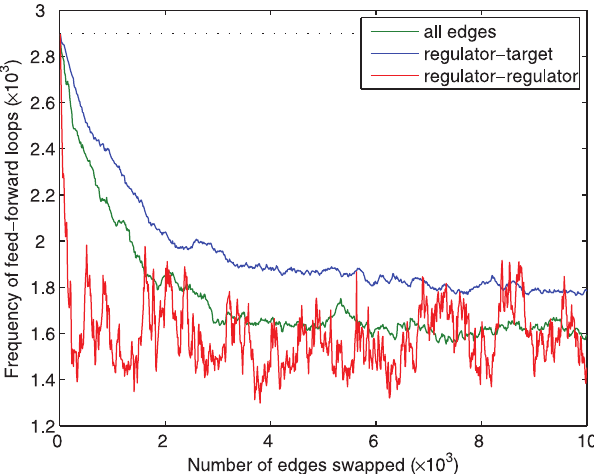
Figure 4. Frequency of FFL Motif under Different Randomization Conditions The curves were generated by starting with the observed network and swapping randomly selected pairs of edges. The green curve corre- sponds to randomization of all edges, the red curve includes random- ization of regulatory connections between TFs, and the blue curve randomization of edges between TFs and genes with k out ¼ 0, which are referred to as target